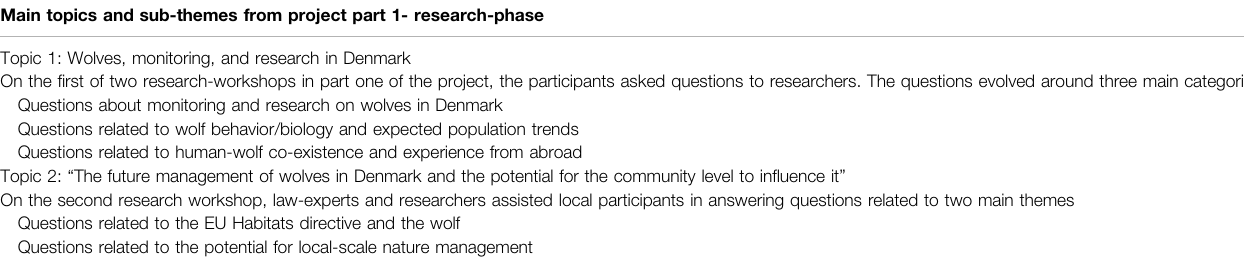
TABLE 4 | Types of questions raised during the two research workshops of the fi rst loop of the WDP,